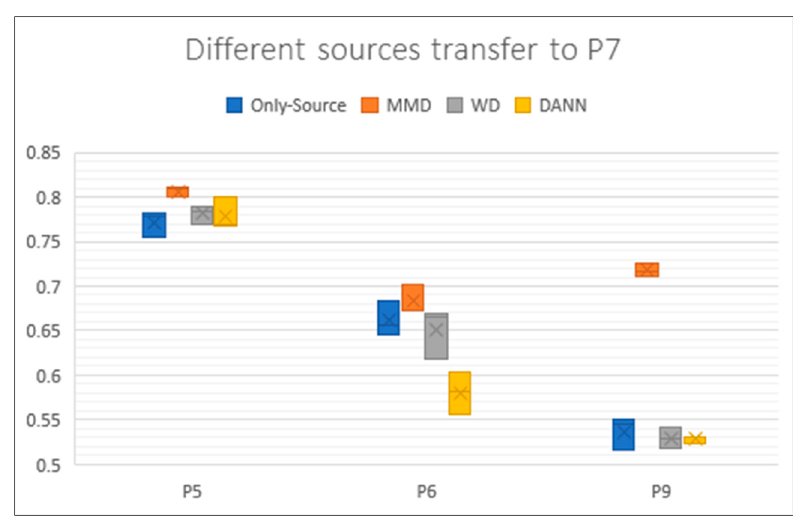
Figure 8. Boxplot of results for P5, P6 and P9 transferring to P7. Each box contains three results. Different colors represent different methods. The y axis represents the accuracy rate of these experiments.